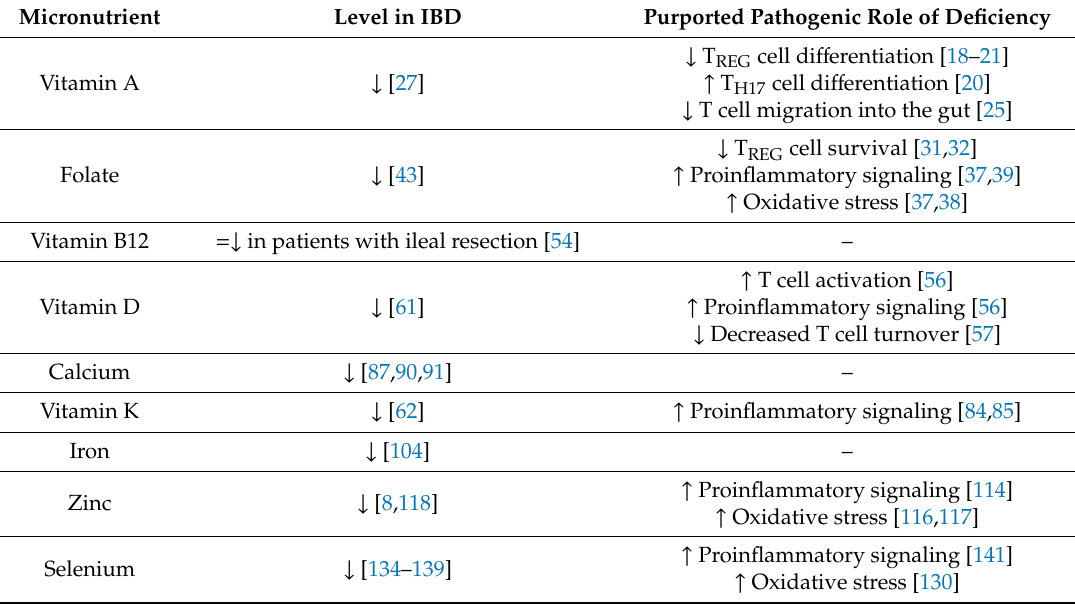
Table 1. Immune implications of micronutrient deficiencies in